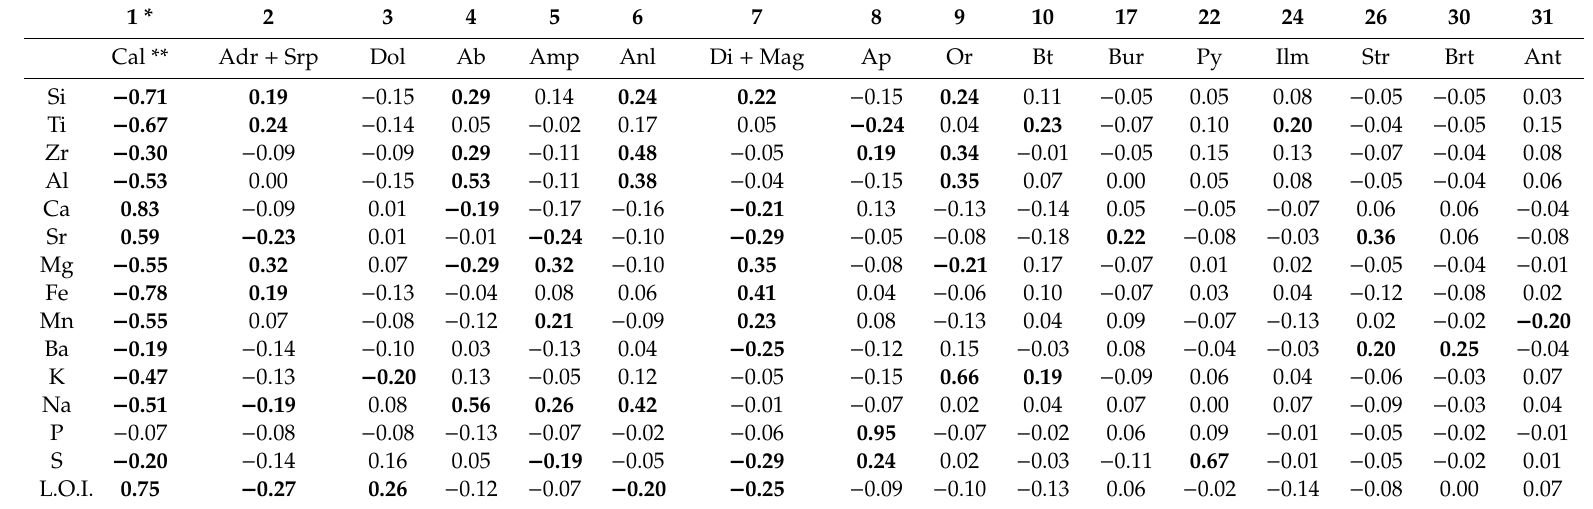
Table 2. Factor loadings of geochemical variables for some interpretable